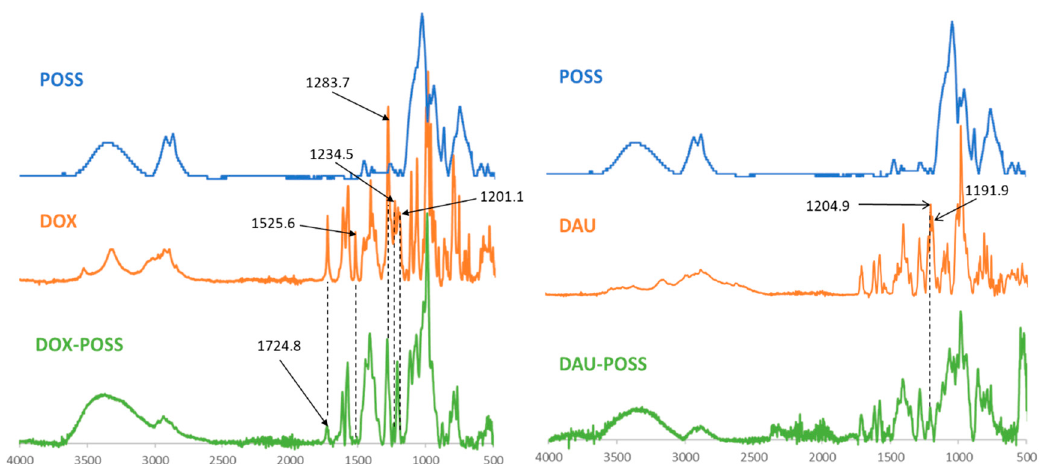
Figure 3. Fourier transform infrared spectroscopy (FTIR) spectra of doxorubicin (DOX), daunorubicin (DAU) and their complexes with polyhedral oligomeric silsesquioxane (POSS).